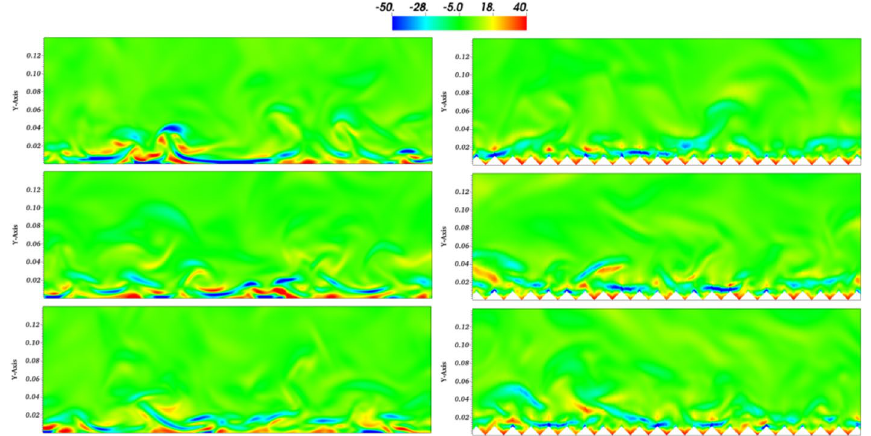
Fig. 20 Distribution of spanwise vorticity fluctuation w z ’ in three moments (Left: smooth flat-plate case; Right: riblets-controlled